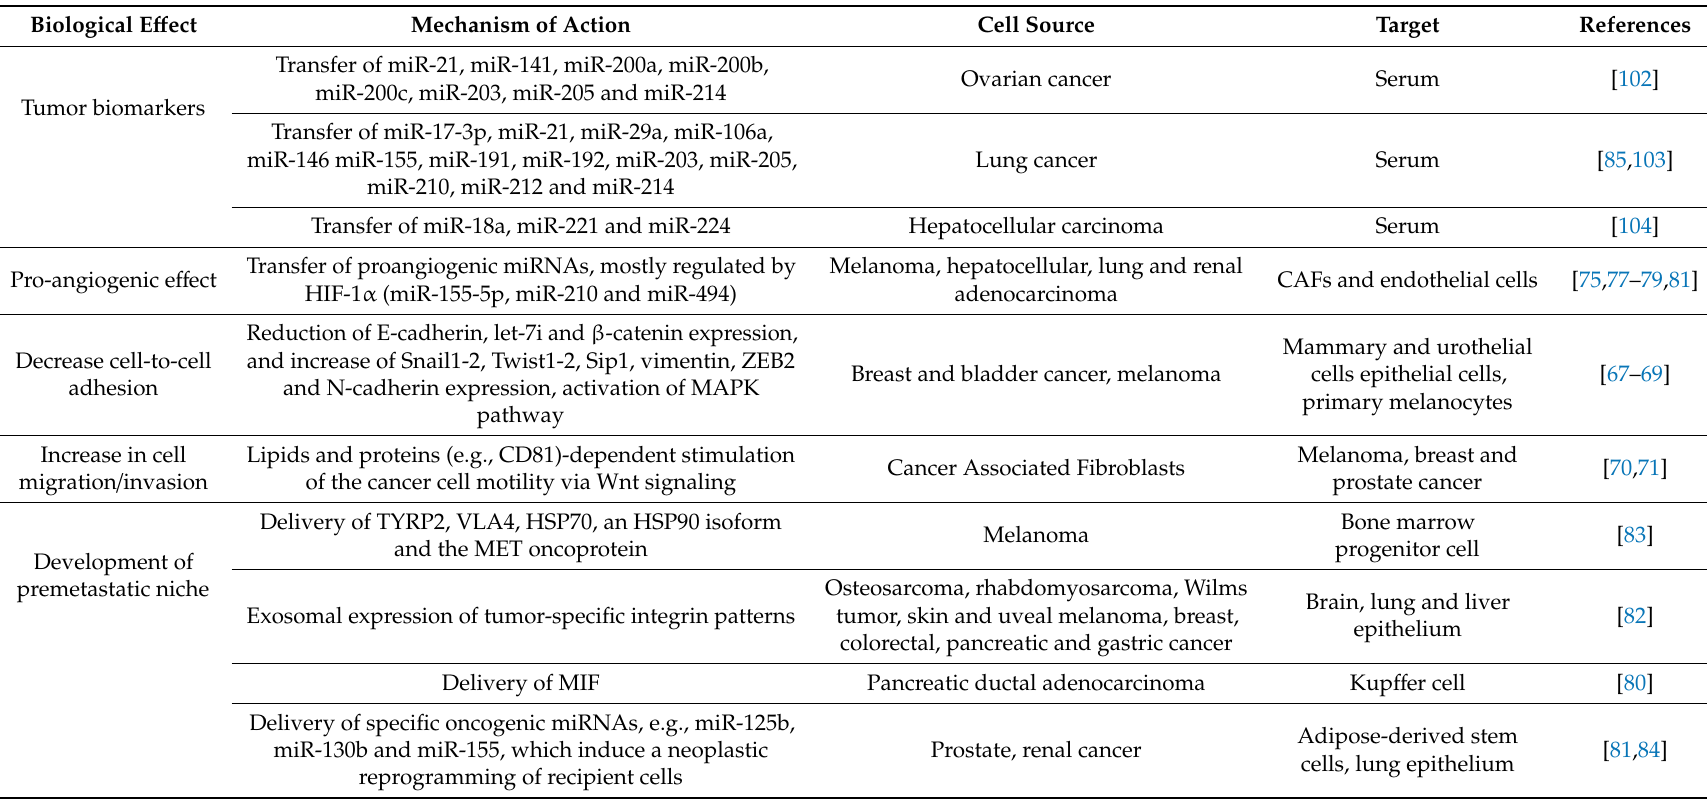
Table 2. Role of EVs as biomarkers of tumor progression. Cancer-derived EV content has been proposed as a tumor biomarker and has been related to several processes involved in tumor